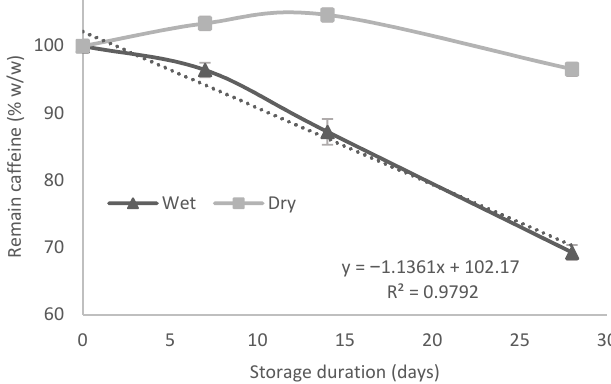
Figure 4. Evolution of the remain caffeine in wet ( ▲ ) and dry ( ) spent coffee grounds after four weeks storage in a closed flask at room temperature. A 4 h Soxhlet extraction has been performed with water to remove totally the caffeine.